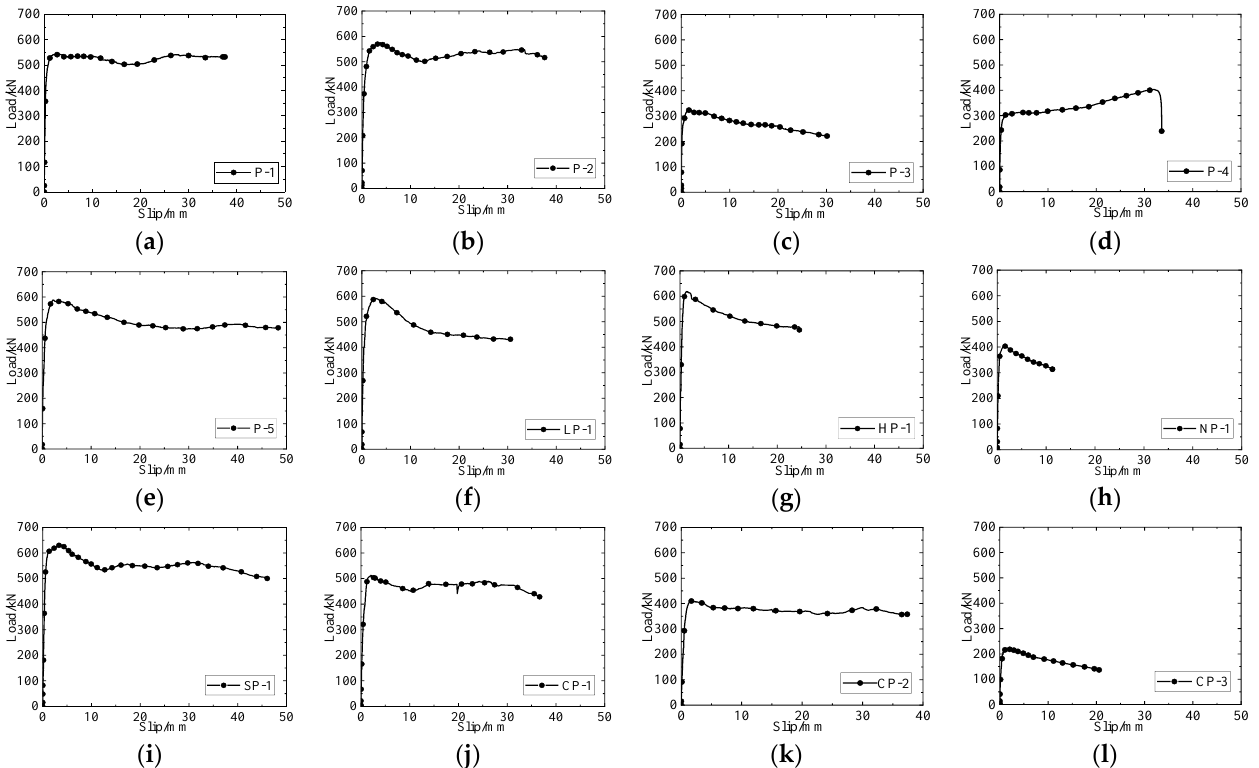
Figure 13. Load – slip curves: ( a ) P-1 ; (b) P-2 ; ( c ) P-3 ; ( d ) P-4; ( e ) P-5; ( f ) LP-1; ( g ) HP-1; ( h ) NP-1; ( i ) SP-1; ( j ) CP-1; ( k ) CP-2; ( l ) CP-3.